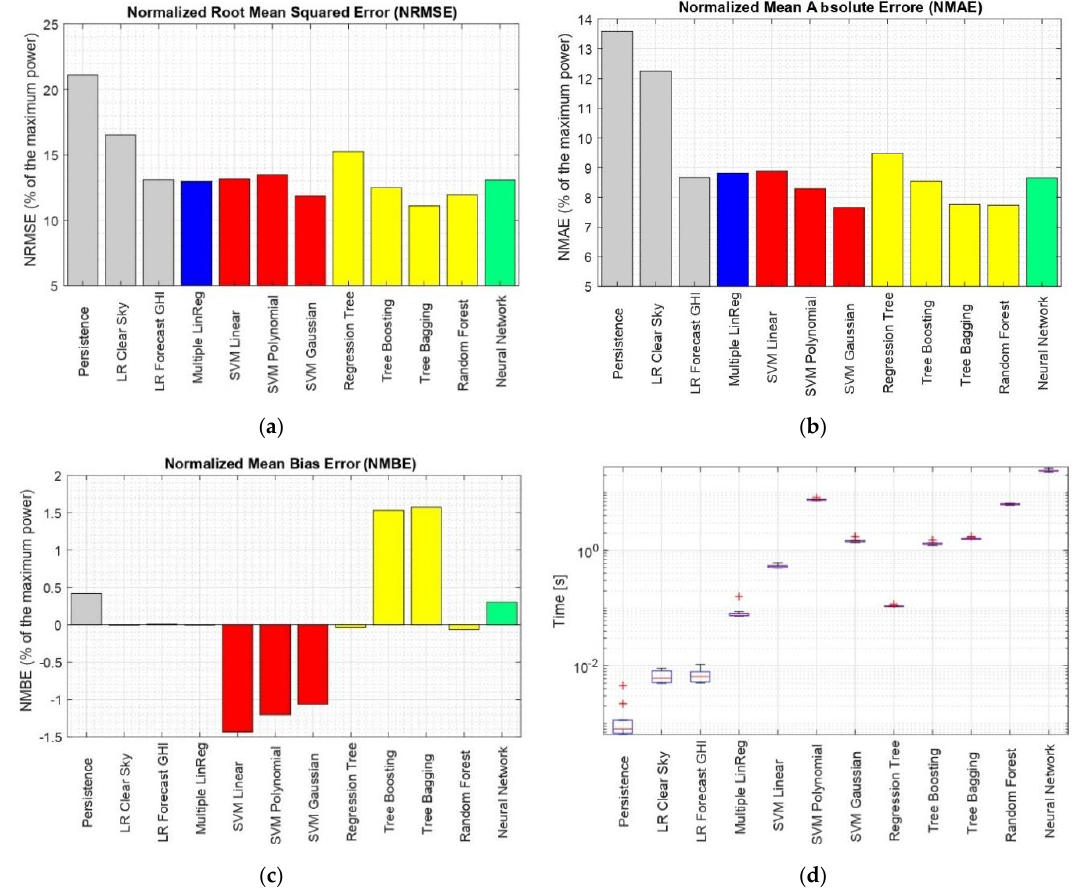
Figure 4. Evaluation of each proposed forecasting technique with respect to the following parameters ( a ) NRMSE (%)—with respect to Pmax; ( b ) NMAE (%)—with respect to Pmax; ( c ) NMBE (%)—with respect to Pmax; ( d ) computational time (s).